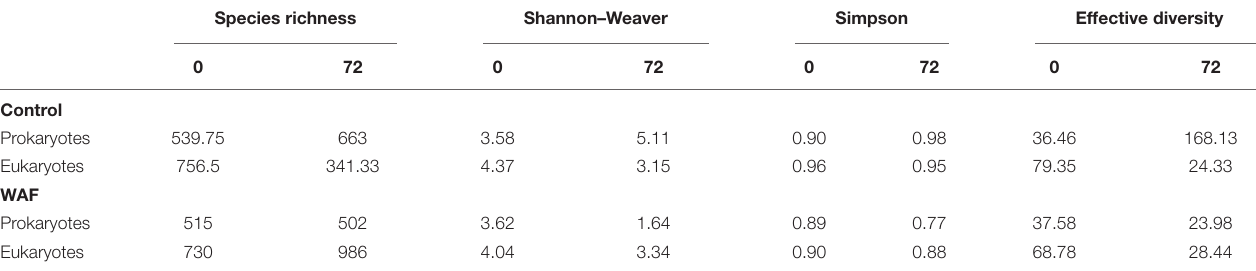
TABLE 1 | Spices richness and diversity of the microbial community in control and oil treatments at time 0 and 72 h of the long-term experiment. Species richness